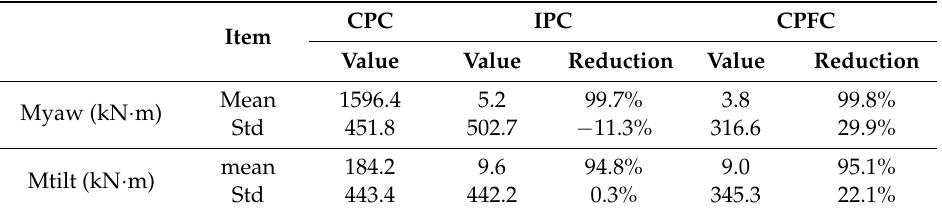
Table 3. The Standard deviation of blade root bending moment and tip deflection.